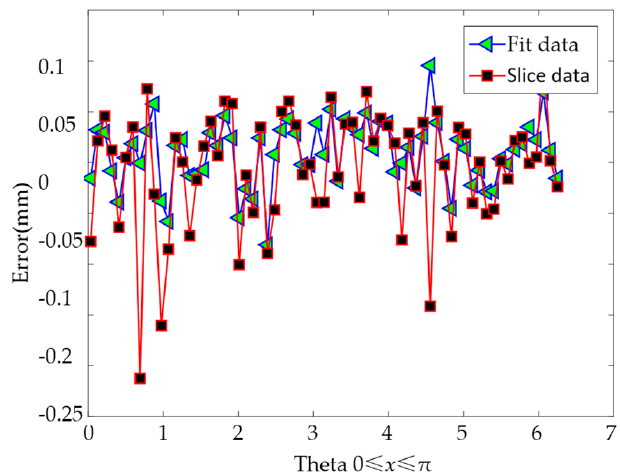
Figure 11. Approximation error of sliced data and fitted data.